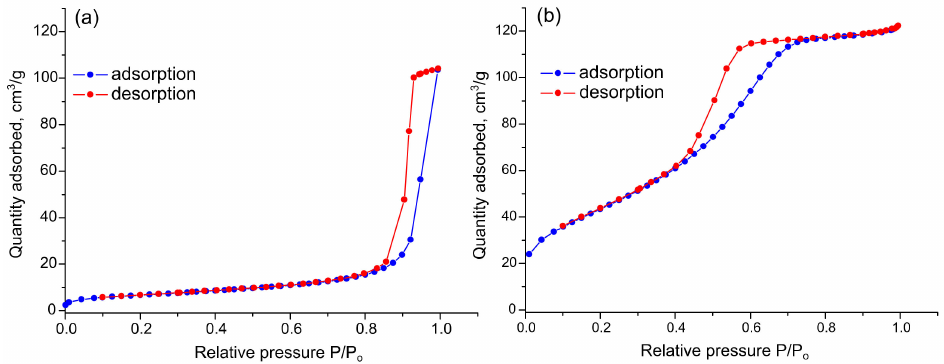
Figure 5. N 2 adsorption and desorption curves of nanocrystalline SnO 2 ( a ) and SnSi19 nanocomposite ( b